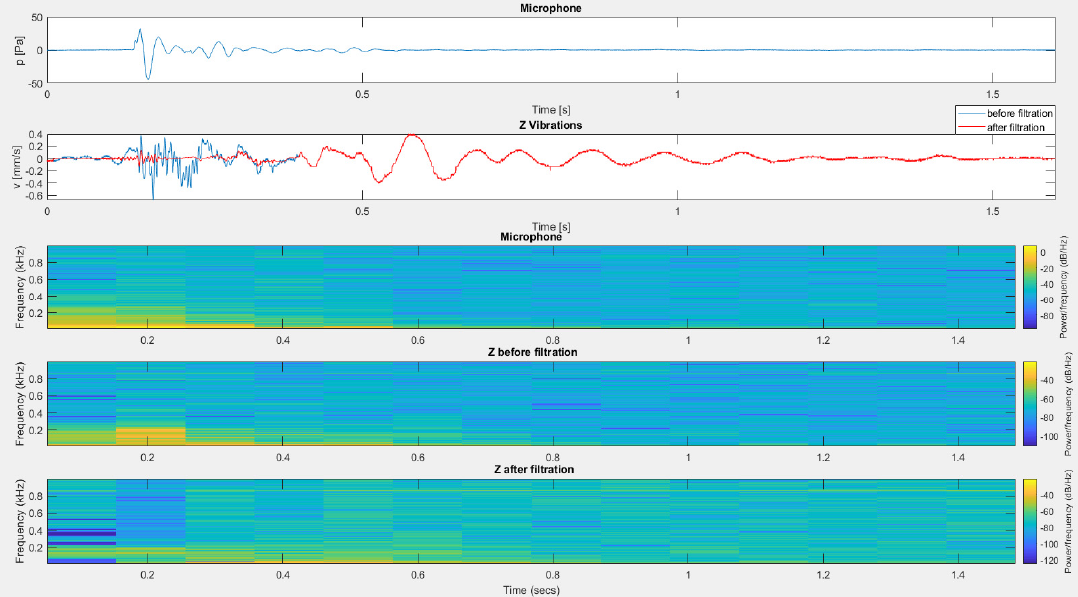
building—an external microphone. Figure 18. The result of using filtering for the vertical component from a sensor located inside the